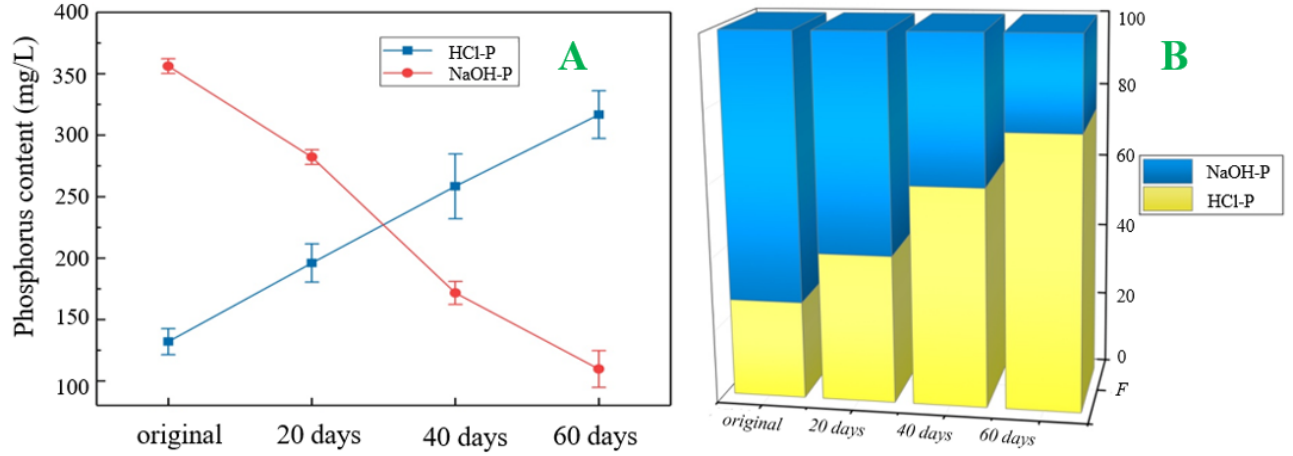
Figure 10. ( A ) 60d HCl-P and NaOH-P content change graph; ( B ) 60d HCl-P and NaOH-P content change percentage graph.